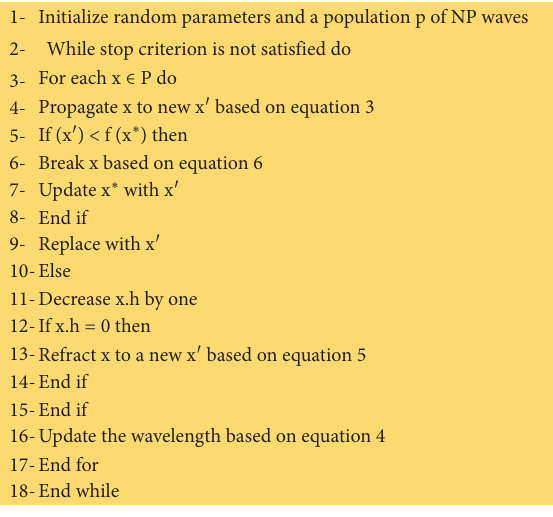
Figure 6: The optimization levels for WWO.